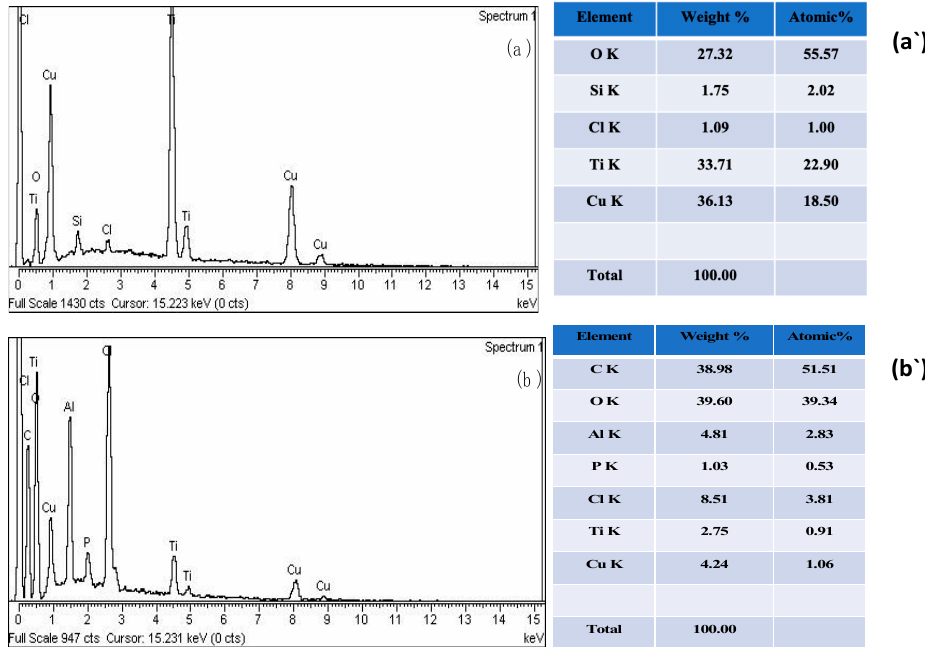
Figure 4. EDS spectrum of ( a , a’ ) CuO-TiO 2 and ( b , b’ ) CMC/CuO-TiO 2 .